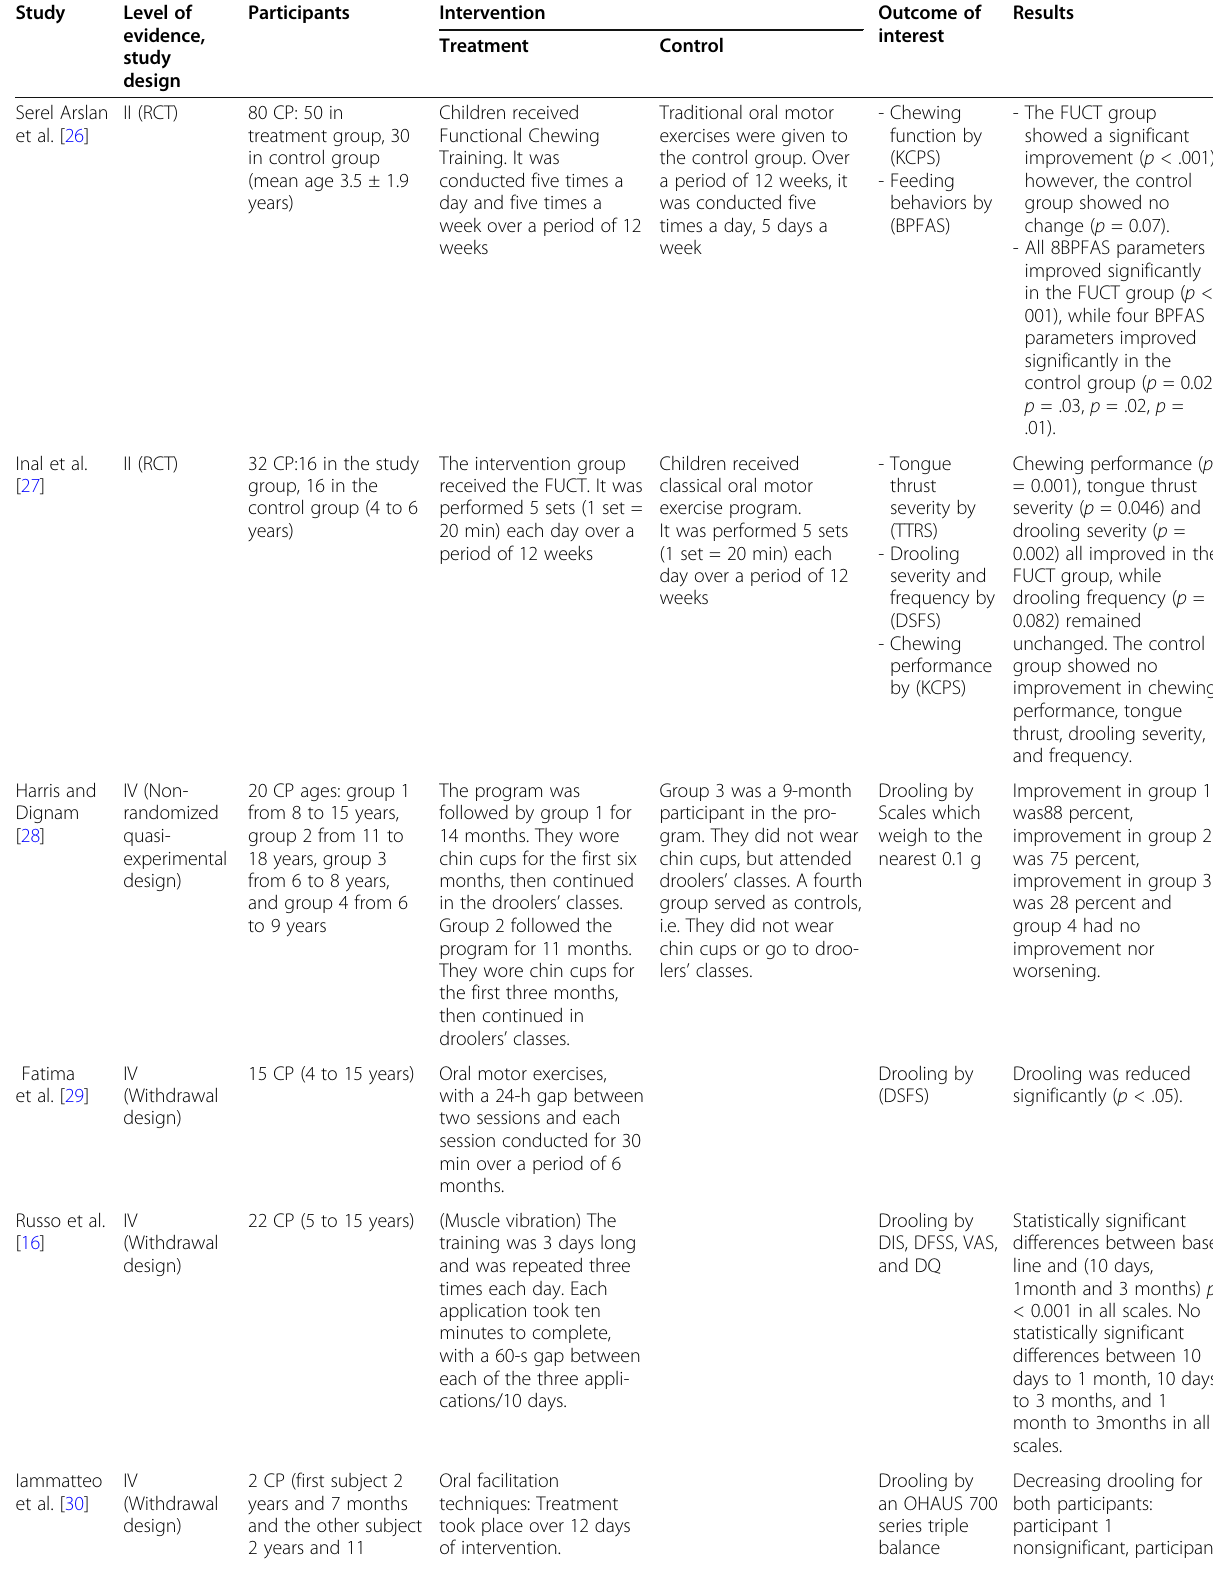
Table 1 Summarizes the characteristics of included